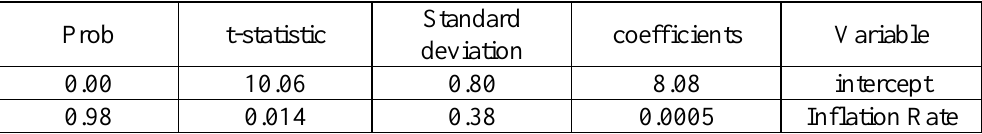
Table 7. The results of Equation 3: The interest rate on bank deposit as a dependent